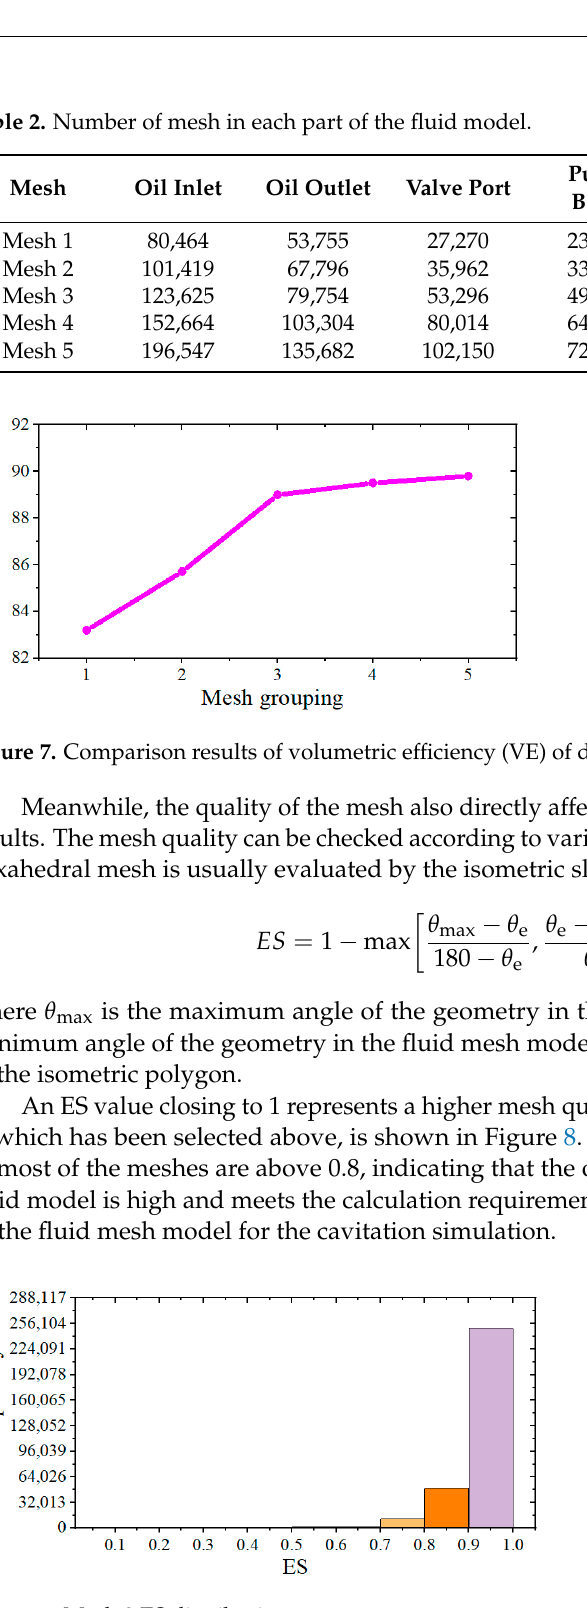
Figure 8. Mesh 3 ES